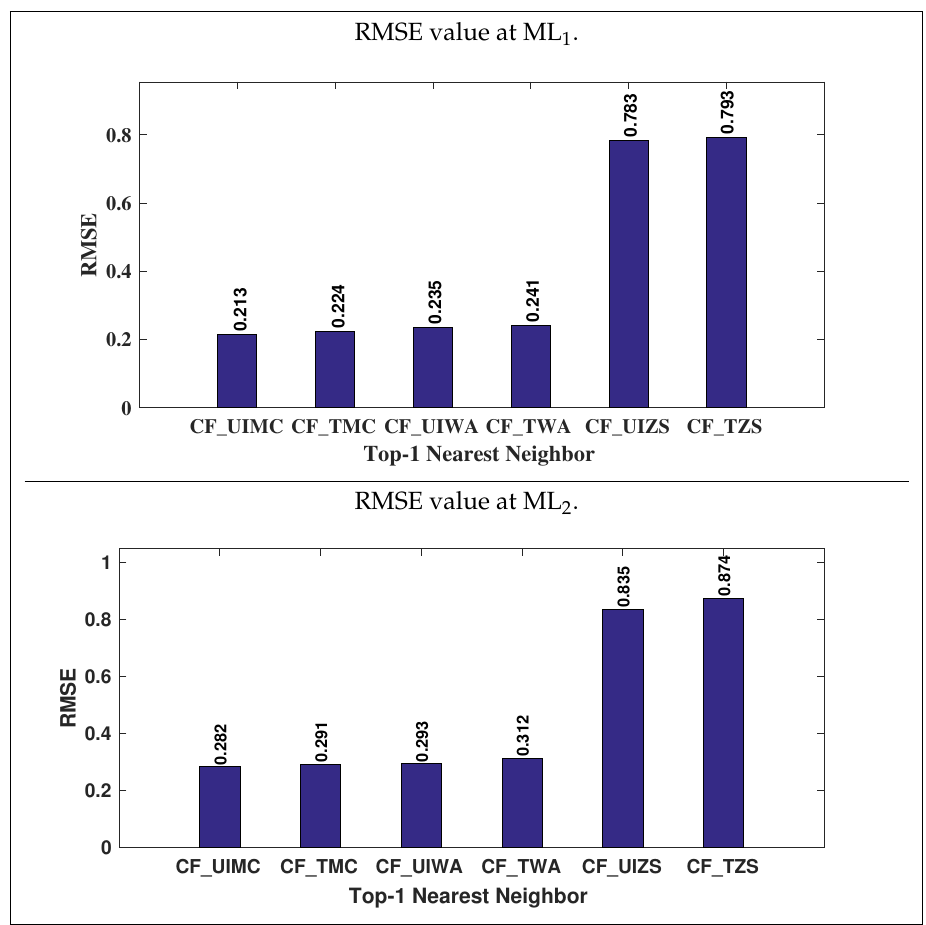
Figure 8. RMSE Value at